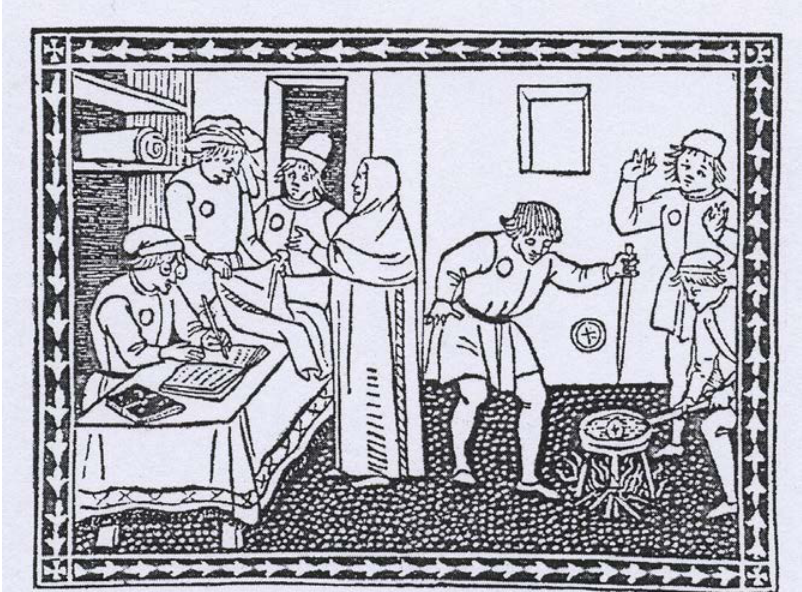
Figure 27 – Rappresentazione del miracolo del corpo di Christo , s.n.t. [but Firenze, Bartolomeo de’ Libri, around 1496], f. a1r, (from Kristeller 1897, n. 180a, 65, cut 48). Cornell University Library, Public Domain,